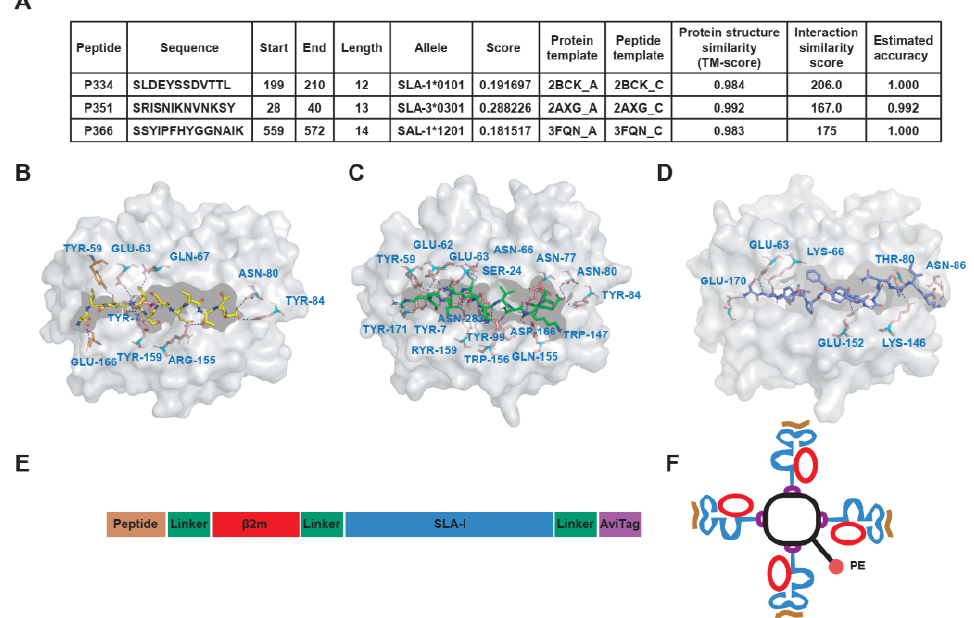
Figure 3. Prediction of SLA-I allele affinity of positive peptides, complex crystal structure analysis, and construction of SLA-I tetramers. ( A ) The affinity of peptides (P334, P351, and P366) and SLA-I alleles was predicted by using IEDB MHC-I Binding Predictions software. The best matching alleles with the highest score were selected. The higher the score is, the better the binding. ( B – D ) The crystal structures of the interaction complex between peptide and SLA-I allele were predicted by GalaxyPepDock protein peptide docking software, and the structure model with the highest estimated accuracy value was selected as the optimal structure of the complex. The crystal structure shows the interaction between amino acids and peptides in the SLA-I binding pocket. P334 interacts with SLA-I*0101 ( B ), P351 interacts with SLA-I*0301 ( C ), and P366 interacts with SLA-I*1201 ( D ). ( E,F ) Schematic diagram of SLA-tetramer construction. The single-chain trimer (SCT) technique was used to connect the peptide, light chain β 2m, and heavy chain SLA-I in series with flexible linkers ( F ). The monomeric SCT was assembled into tetramers by streptavidin with PE fluorescence.